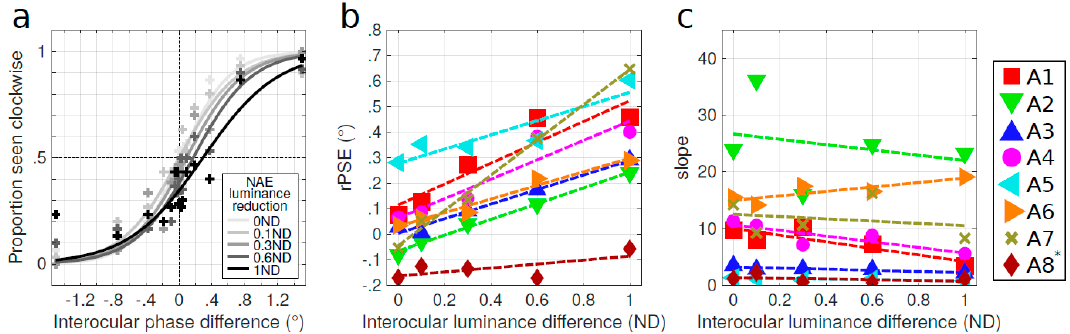
Figure A2. Interocular luminance difference. ( a ) Psychometric functions of the perceived direction of rotation for one representative amblyopic subject (A7) as a function of the interocular phase difference for five luminance conditions. Neutral density (ND) filters were placed in front of the non-amblyopic eye: no-filter, 0.1ND, 0.3ND, 0.6ND, and 1ND from light- to dark-gray symbols. Data points are fitted by a logistic function. ( b ) rPSE as a function of the interocular luminance difference for the individual eight amblyopic subjects. * rPSE values for subject A8 were divided by 10. ( c ) Slopes of the psychometric functions. Dashed lines represent linear regression. Quality of fit and regression parameters are reported in Table S1 (Supplementary Materials, Sheet 4).